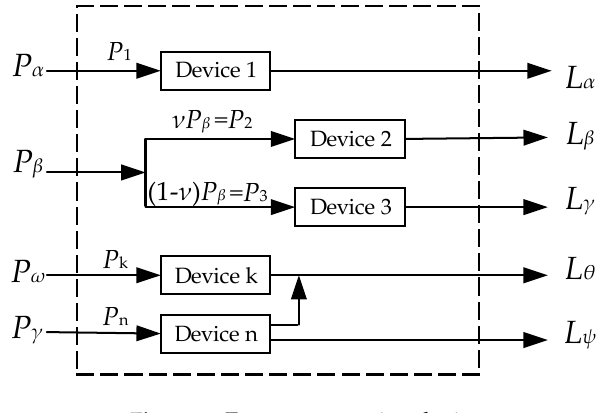
Figure 4. Energy conversion device.